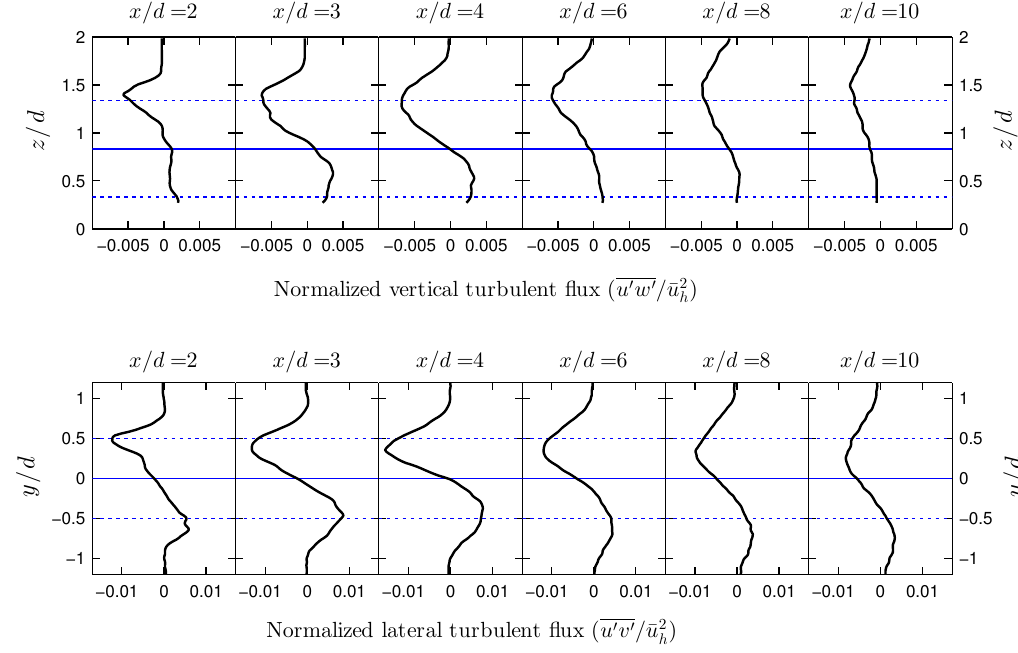
Figure 9. Vertical profiles of the normalized vertical momentum turbulent flux ( top ) and lateral profiles of the normalized lateral momentum turbulent flux ( bottom ) at hub level at different downstream locations. Blue solid lines and blue dashed lines represent the rotor axis and the tip positions, respectively.